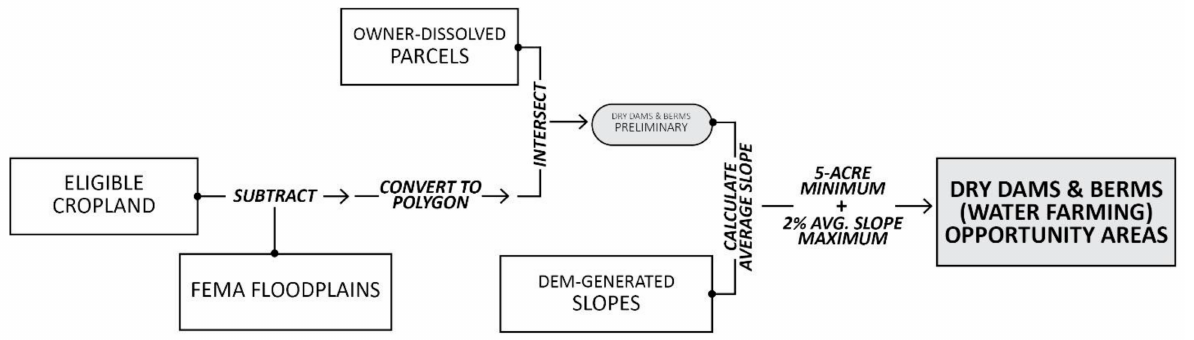
Figure 8. Diagram illustrating the general process of geospatial analysis for identifying Dry Dam and Berm (Water Farming)